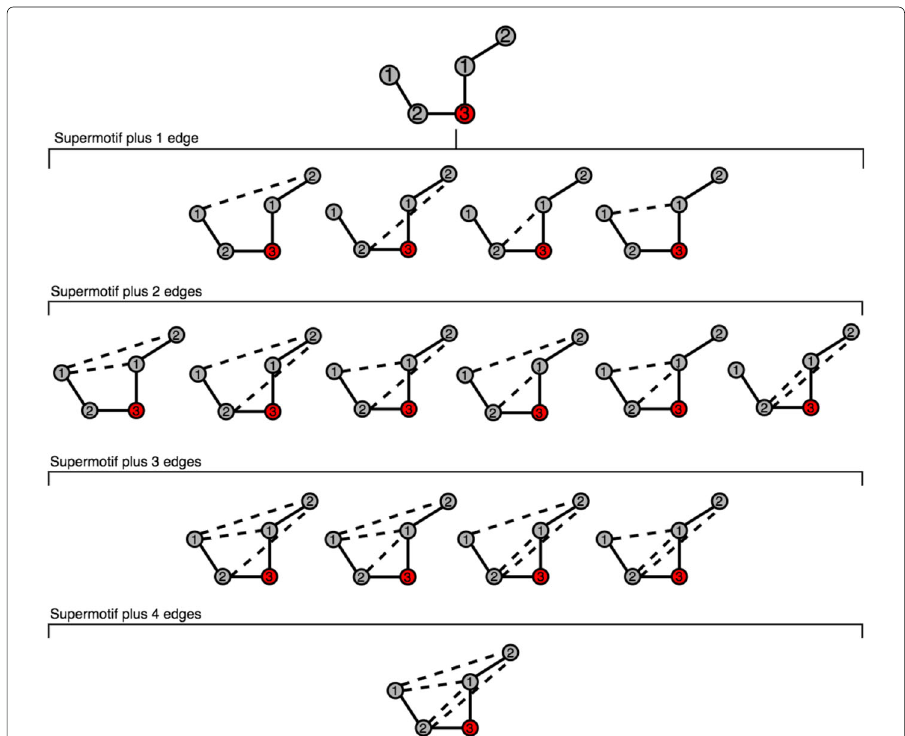
Fig. 9 Expansion set of the 5-nodes path super-motif resulting from the overlap of two NRPs of the 3-nodes path. Starting from the top, the figure shows at each level L all super-motifs that can be built starting from all super-motifs at level L − 1, by adding exactly one edge between non-overlapping nodes in all possible